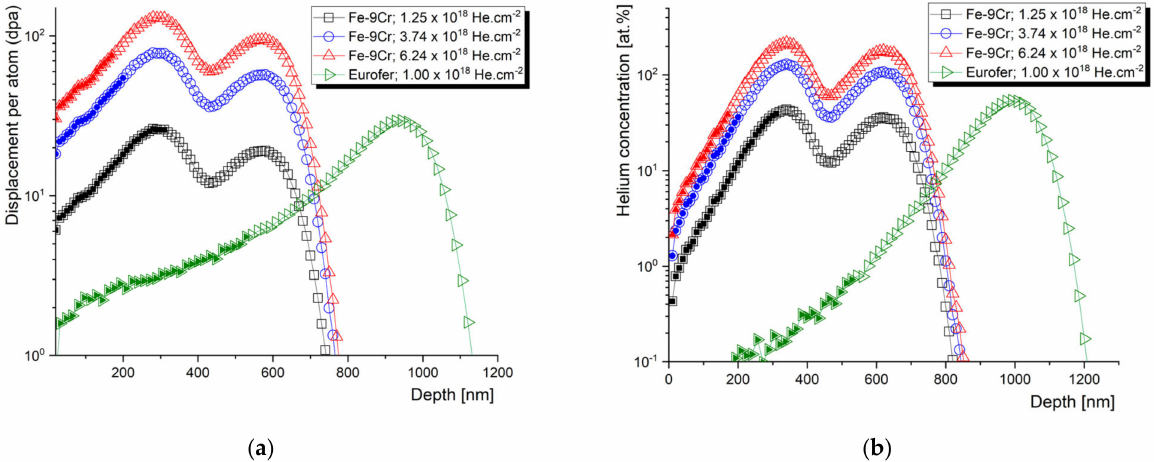
Figure 7. SRIM calculated displacement damage ( a ) and helium concentration ( b ) profiles proposed for slow positron lifetime